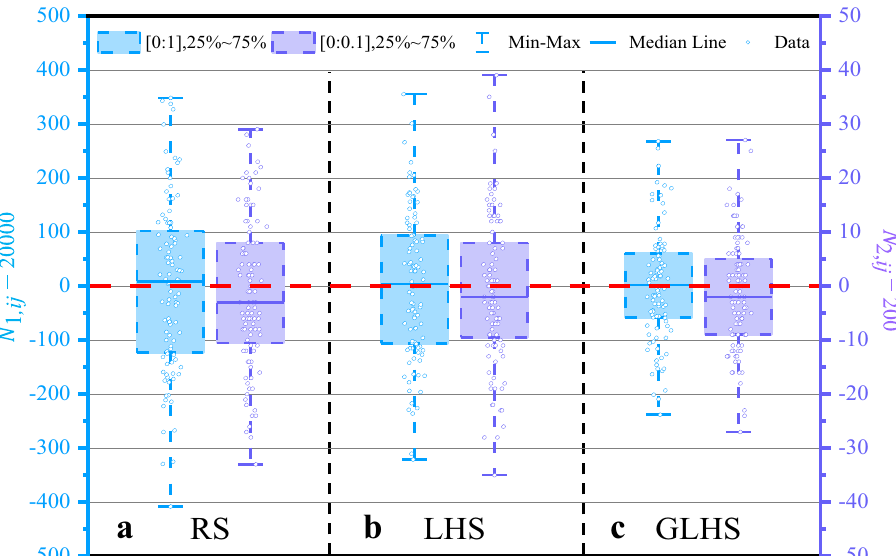
Figure 3. Comparison of three types of sampling. The blue Y-axis on the left of the figure represents the number of data N 1, ij in 100 equal square data collections area of (cid:31) 1 right represents the number of data N 2, ij in 100 data collections area of (cid:31) 2 the data distribution within the range of 25%-75% of N 1, ij and N 2, ij . The solid line in the box is the median line of data distribution, the line cap represents the maximum and minimum value of data distribution. The red dotted line represents the ideal number of data distributions, 20,000 and 200